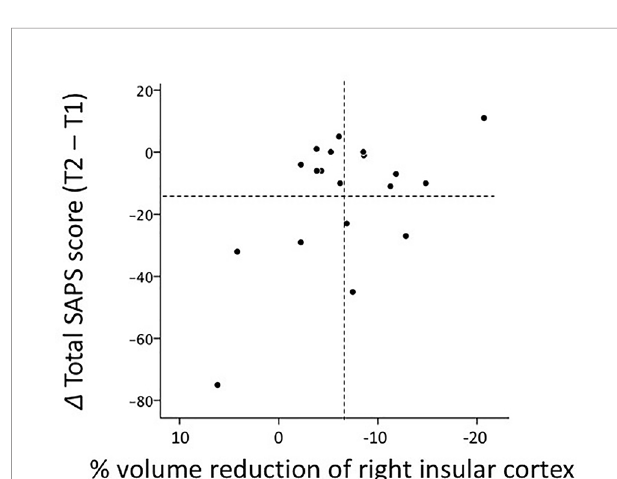
FIGURE 2 | Absolute volume of the insular cortex in participants. Due to the absence of the signi fi cant effect of subregion (i.e., short and long insular cortices), we showed the volumes of the whole insular cortex. The values of baseline (T1) and follow-up (T2) scans in each participant are connected with a straight line. Horizontal bars indicate the means of each group.